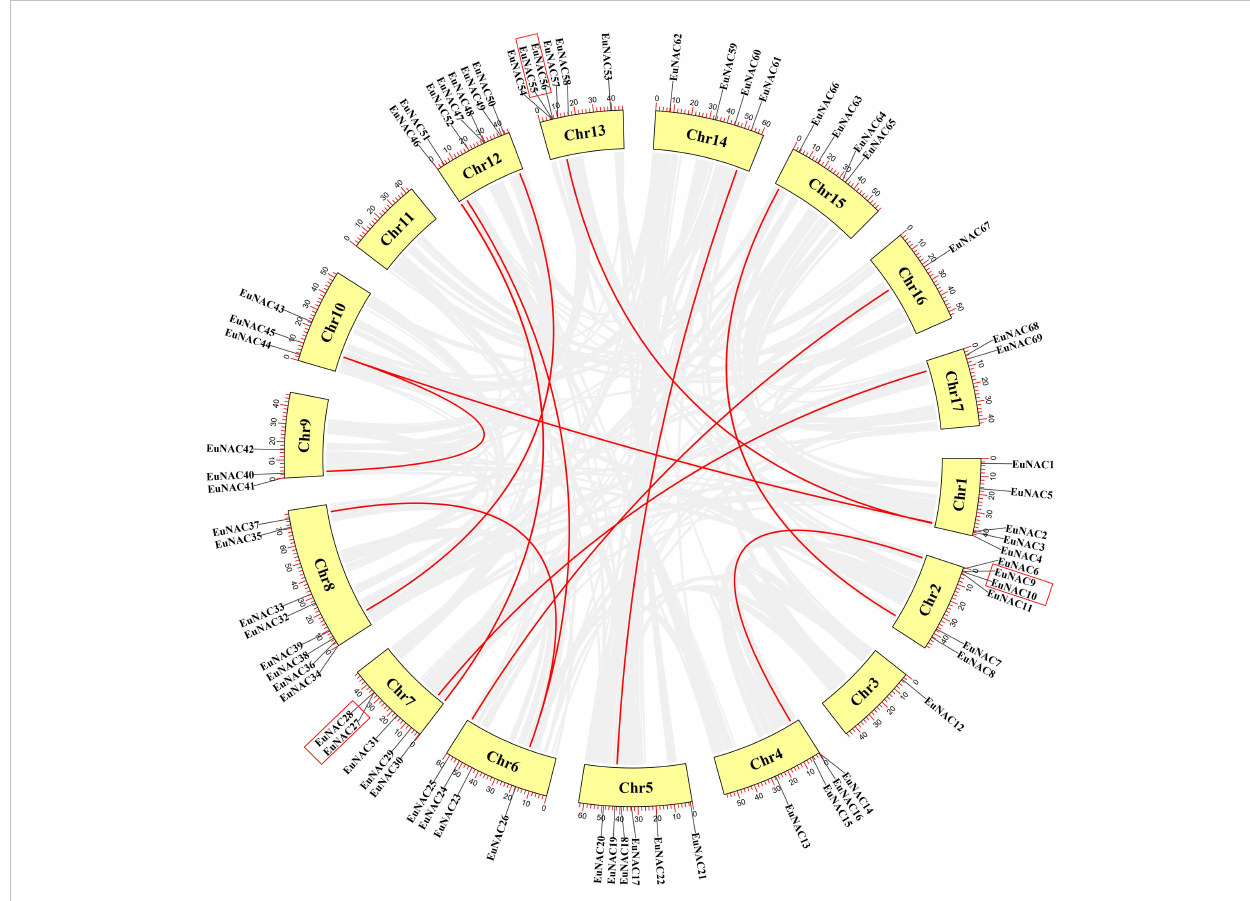
FIGURE 5 Schematic representations for the chromosomal distribution and interchromosomal relationships of EuNAC genes. Gray lines indicate all synteny blocks in the pineapple genome, and the red lines indicate duplicated NAC gene pairs. The tandem duplicated genes were highlighted with a red rectangle. The red scale bar marked on the chromosome represents the length of the chromosome (Mb). The chromosome number is indicated at the bottom of each